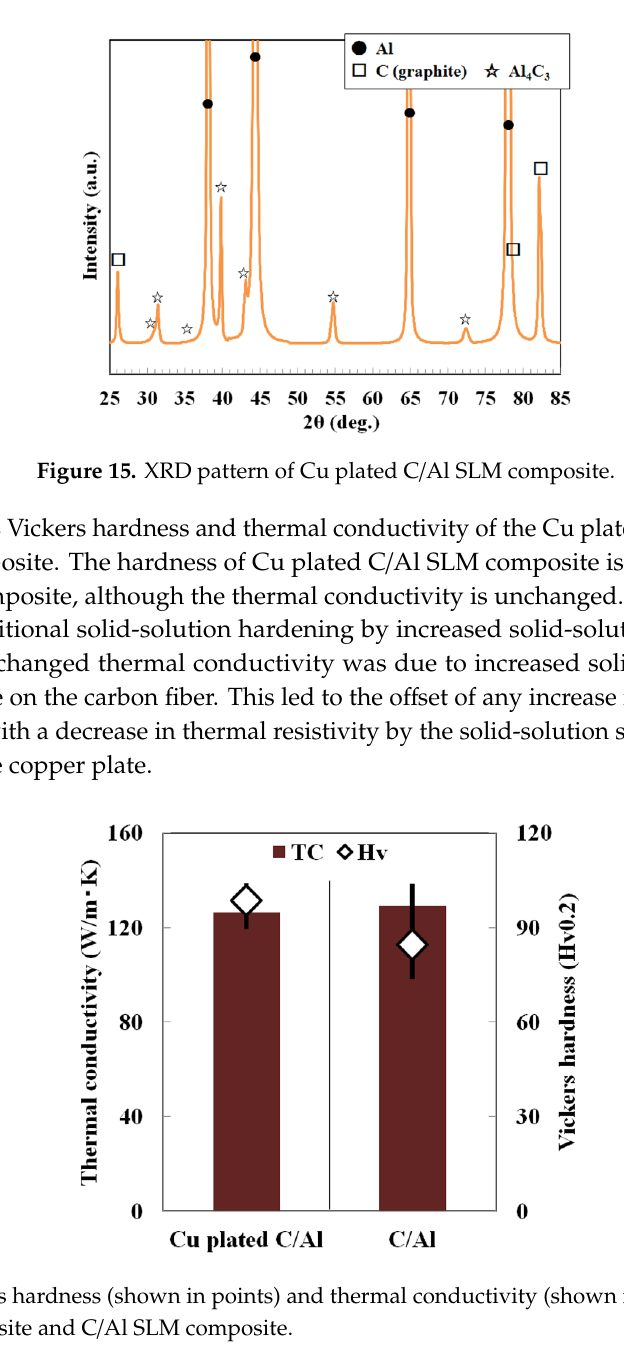
Figure 14. Enlarged ( a ) OM and ( b ) SEM images of a vertical plane of the Cu plated C/Al SLM composite.